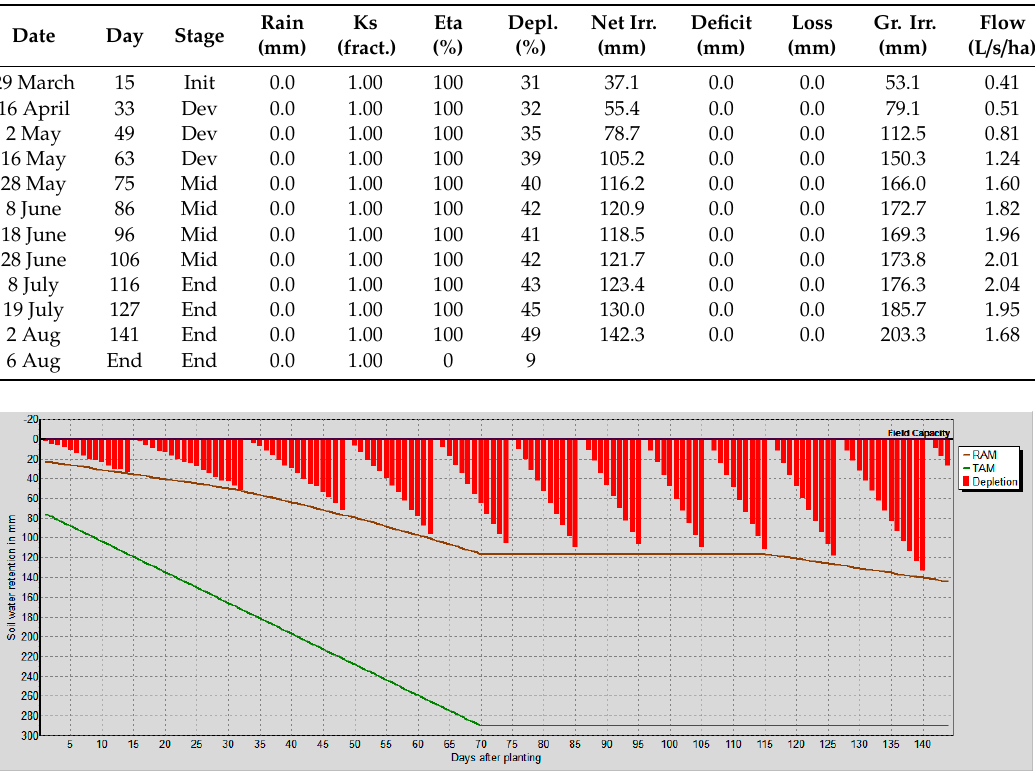
Table 10. Irrigation schedules for tomatoes.